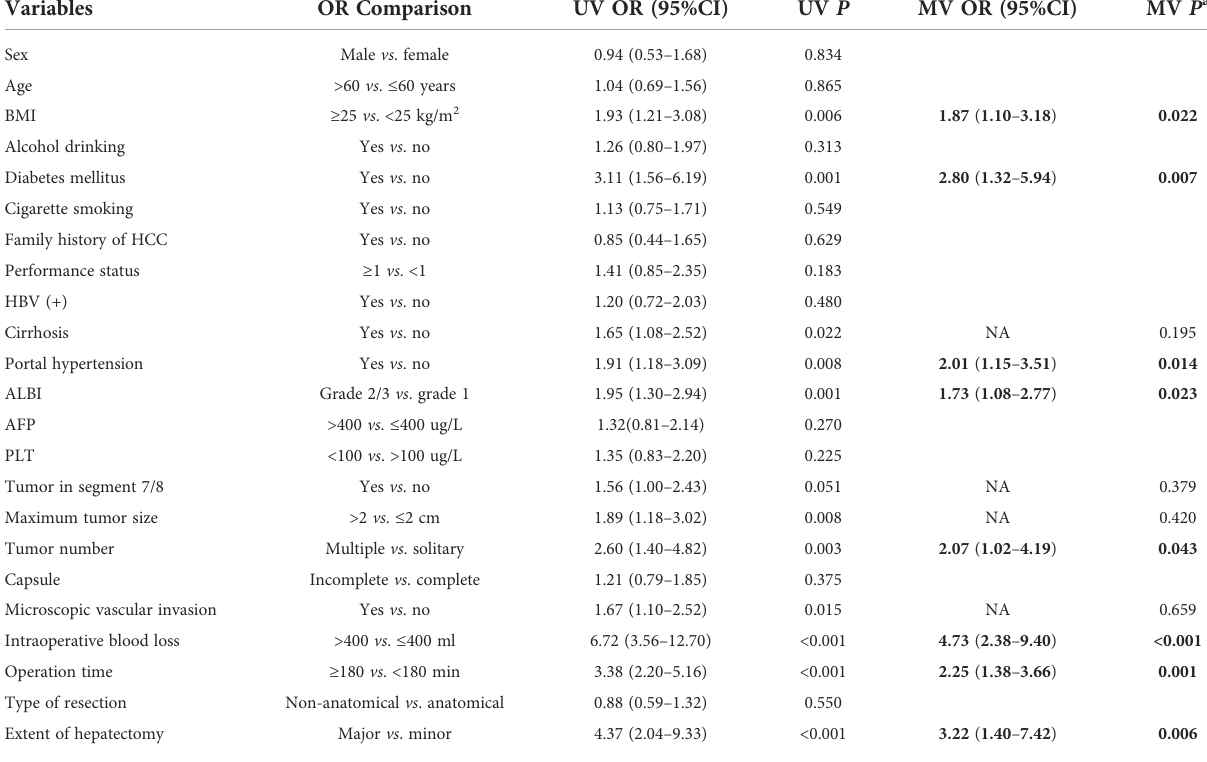
TABLE 3 Univariable and multivariable logistic regression analyses of risk factors associated with non-TO following laparoscopic hepatectomy for HCC.